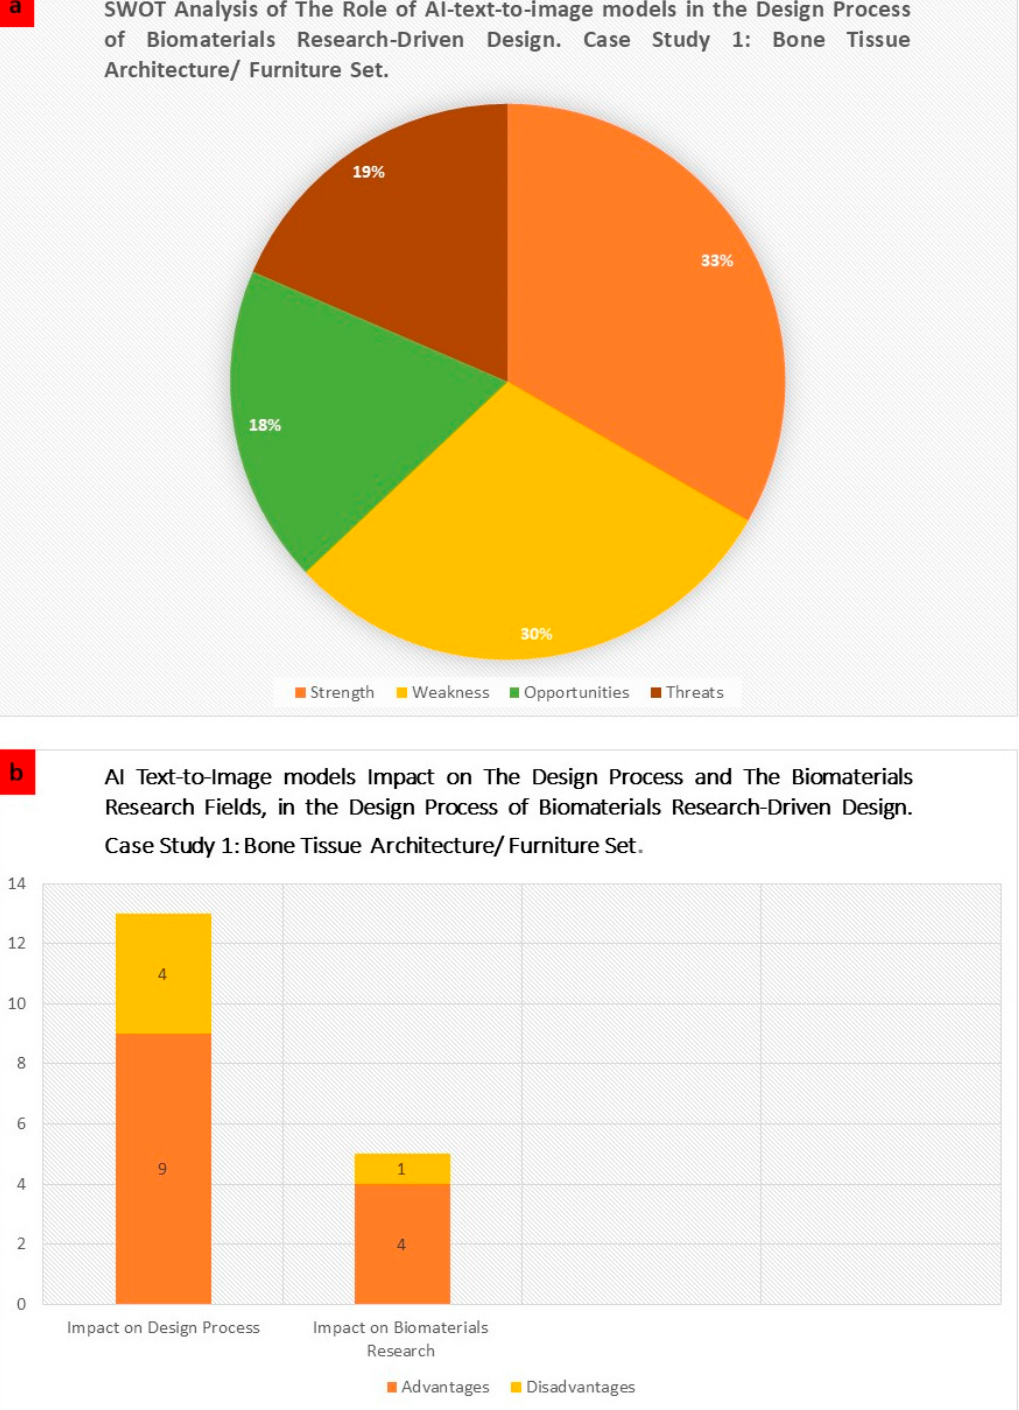
Figure 3. The bone chair biomineralization research project: statistical analysis of the SWOT analysis of the role of AI text-to-image model integration in the biomaterials research-driven design process. ( a ) Statistical estimation of weights of strengths, weaknesses, opportunities, and threats from the SWOT analysis. ( b ) Statistical estimation of the impact of AI text-to-image models on the design process and the biomaterials research fi eld.